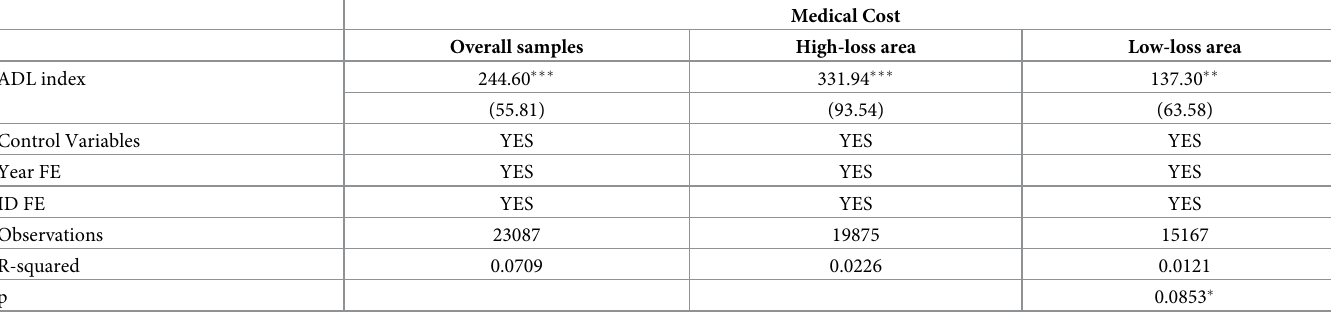
Table 5. Effect of health on medical